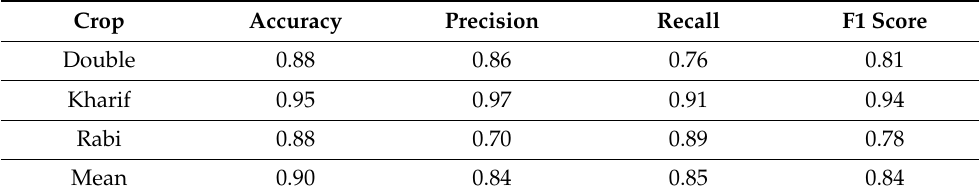
Table 3. Quality